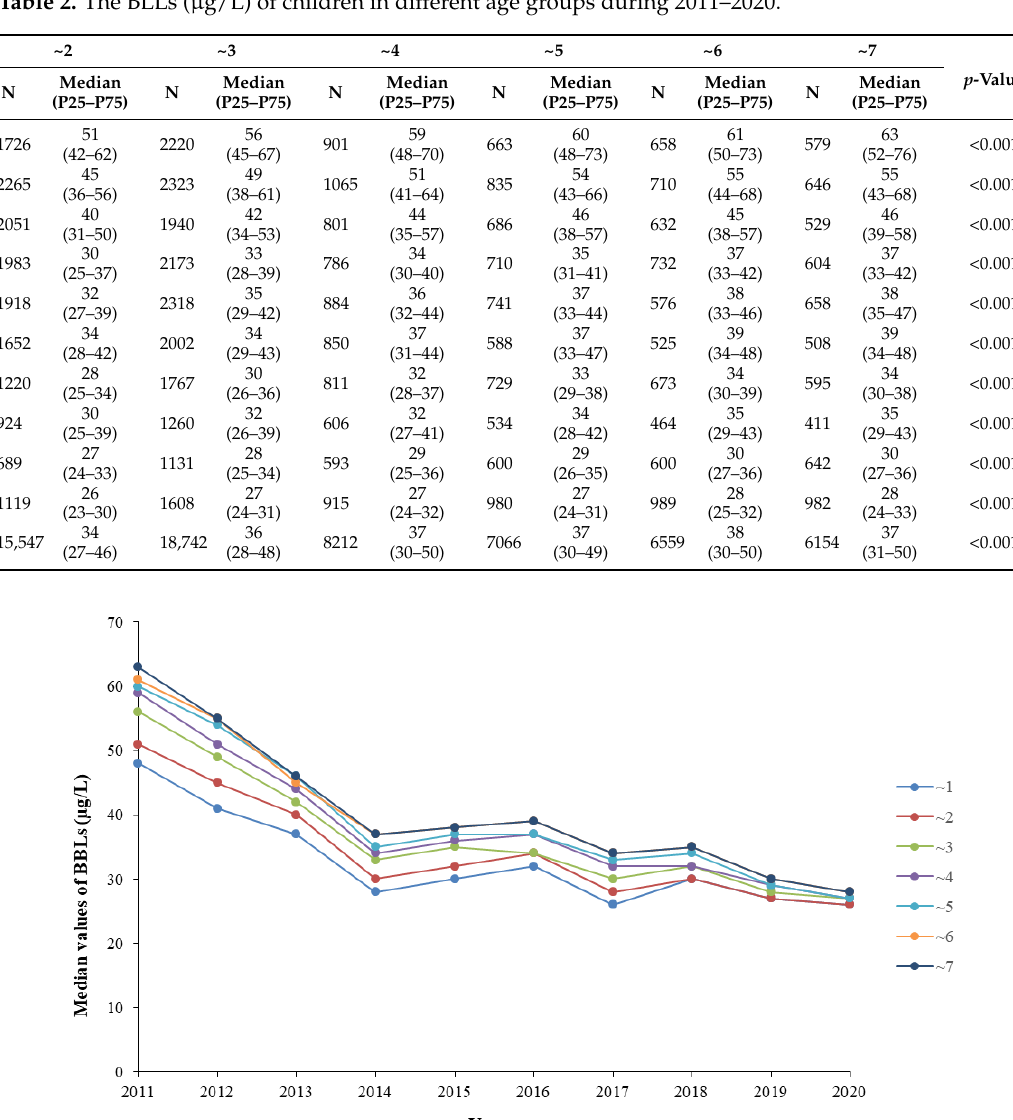
Figure 2. Prevalence of BLLs ≥ 100 μg/L ( A ) and BLLs ≥ 5 0 μg/L ( B ) from 2011 to 2020. 3.3. Treatment Efficiency To evaluate treatment efficiency, 73 participants were recruited into two groups. The first included 54 children with high blood lead (1 00 ≤ BLLs ≤ 19 9 μg/L ), and the second included 19 children with mild lead poisoning ( 200 ≤ BLLs ≤ 249 μg/L ). After a period of